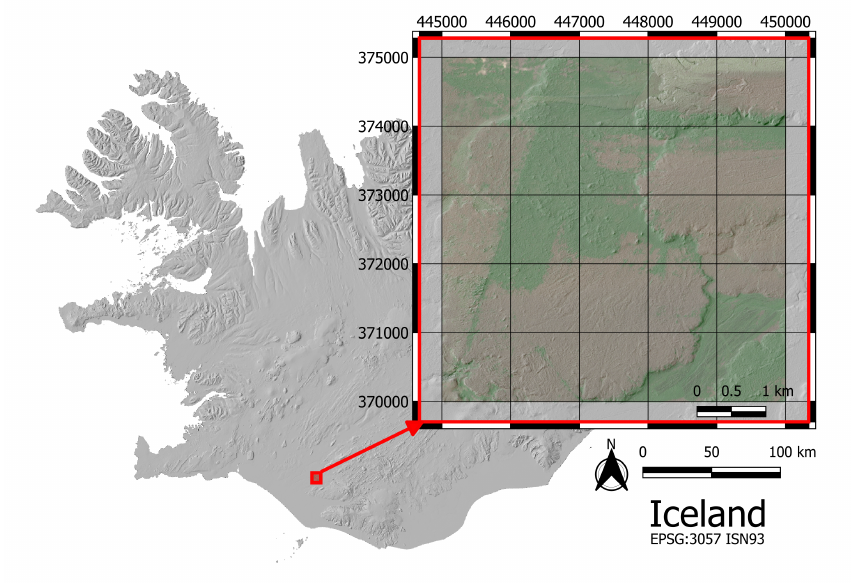
Figure 3. Test site location, with coordinates geolocated in EPSG:3057